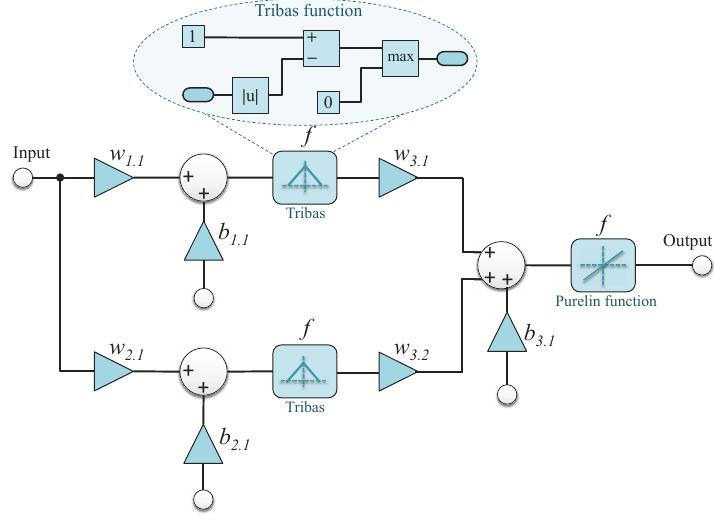
Figure 7. NN model